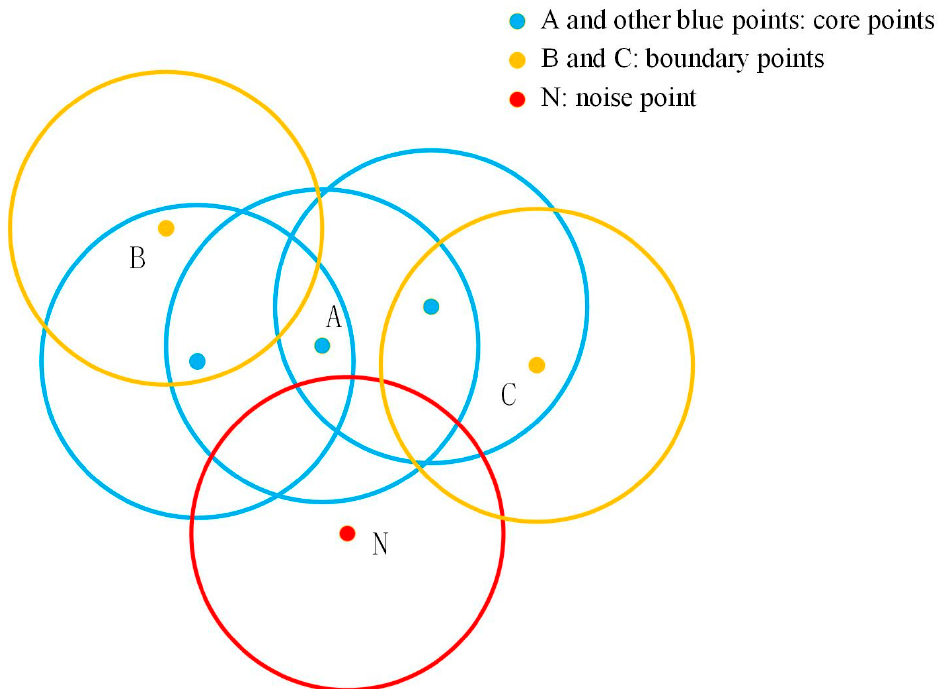
Figure 3. Data point types of the DBSCAN algorithm.